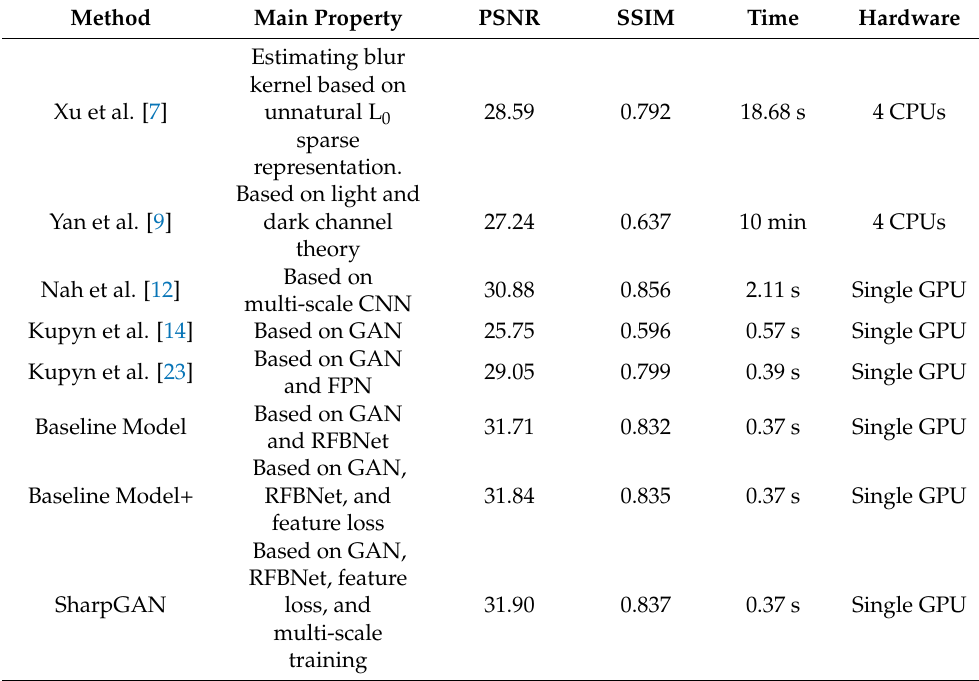
Table 3. The experimental results of different methods on the SMD dataset.